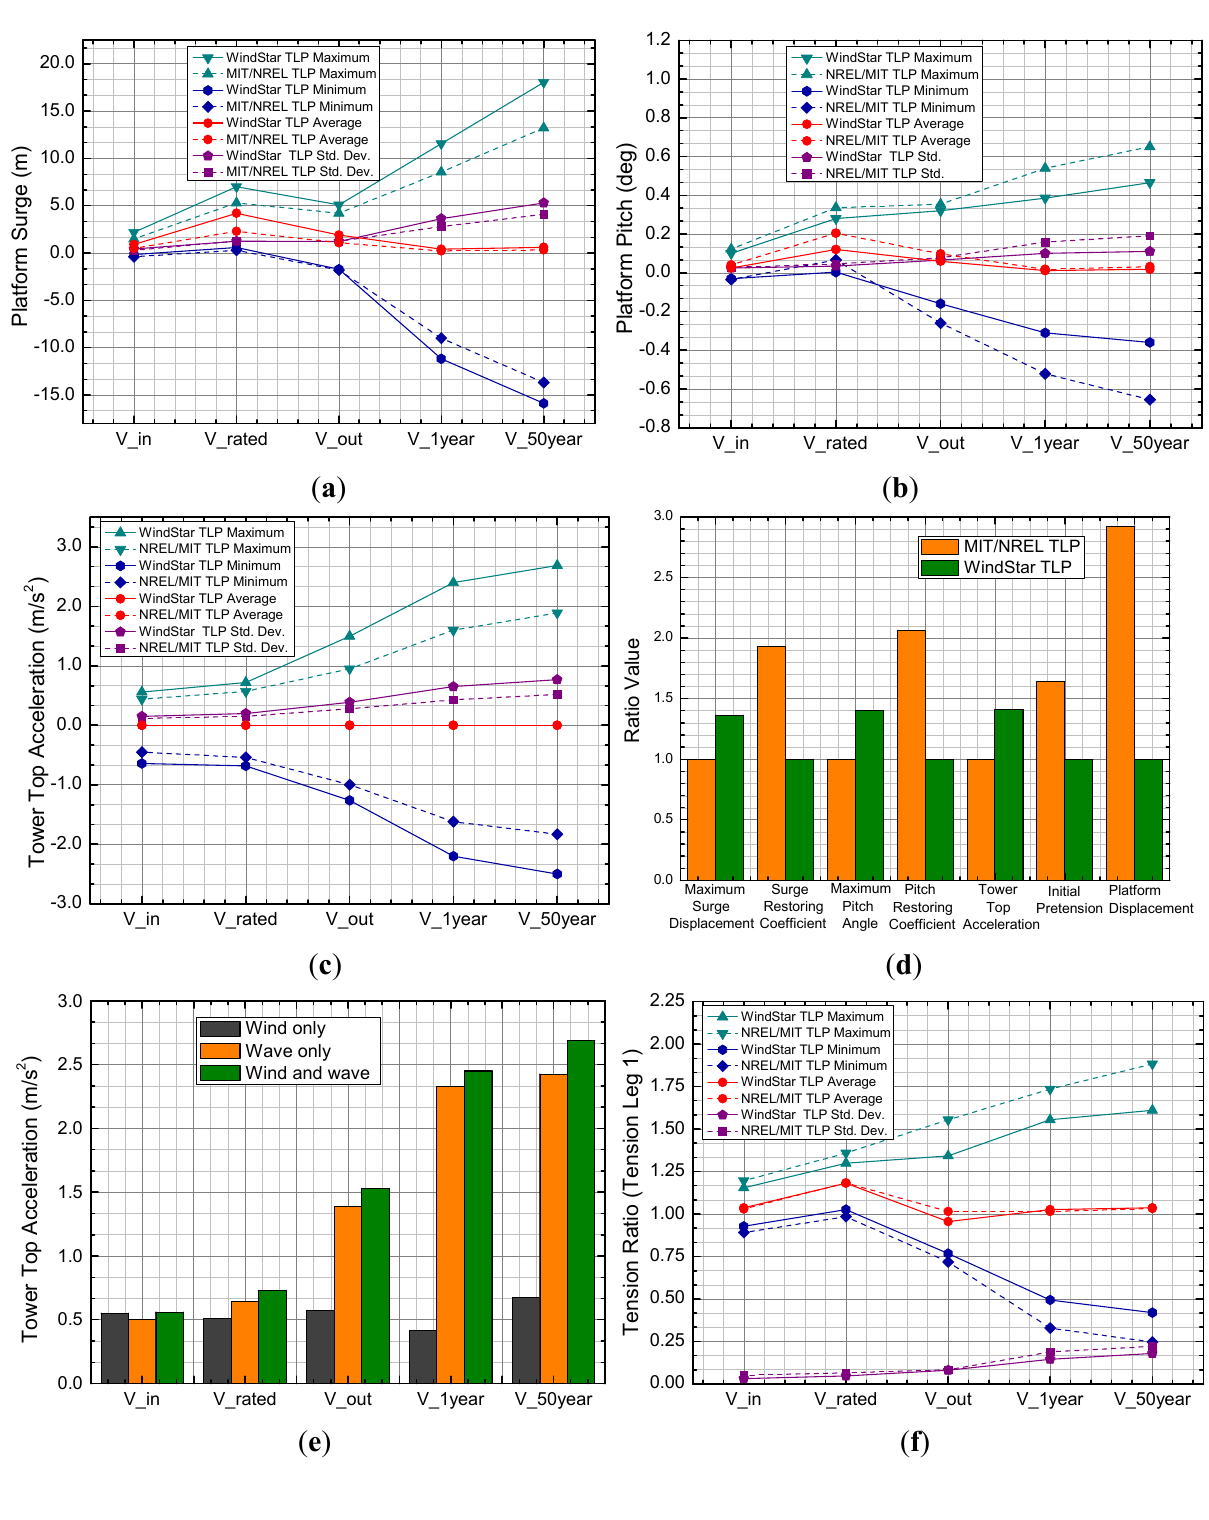
Figure 14. ( a ) Platform surge vs. wind speed; ( b ) Platform pitch vs. wind speed; ( c ) Comparisons of two TLP systems; ( d ) Tower top acceleration vs. wind speed; (e) Wind and wave effect on tower top acceleration; ( f ) Tendon ratio vs. wind